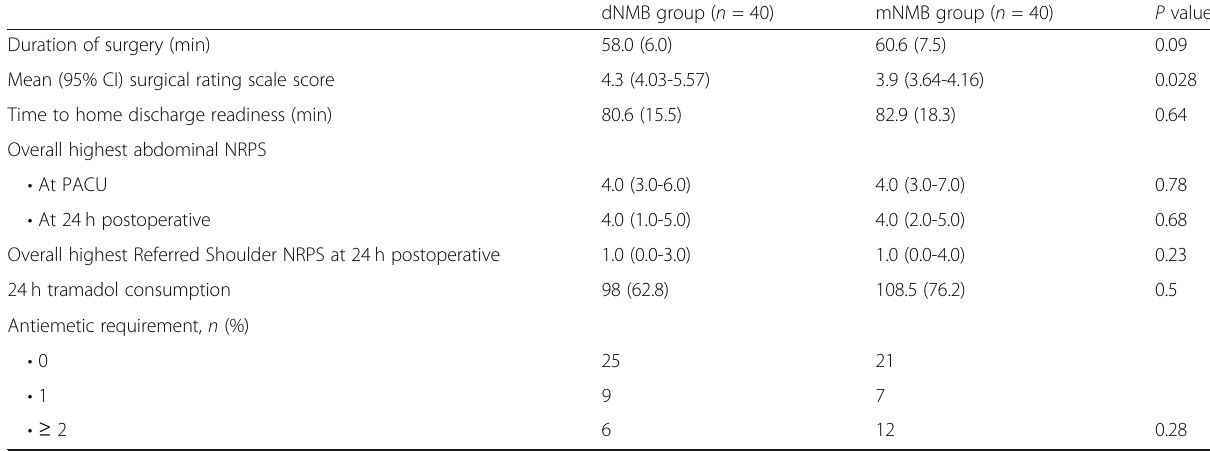
Table 4 Duration of surgery, surgical rating scale score and postoperative recovery, and medication use between the groups. Values are mean (95% CI), median (range), or numbers (proportion) dNMB group ( n = 40)